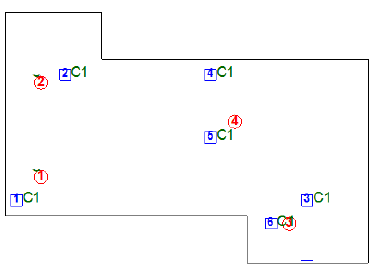
Figure 16. Positions of the decoupling capacitors on the PDN board after optimization (the position and numbers of the ports are circled in red. The input impedance is measured/computed at port numbered “1”).